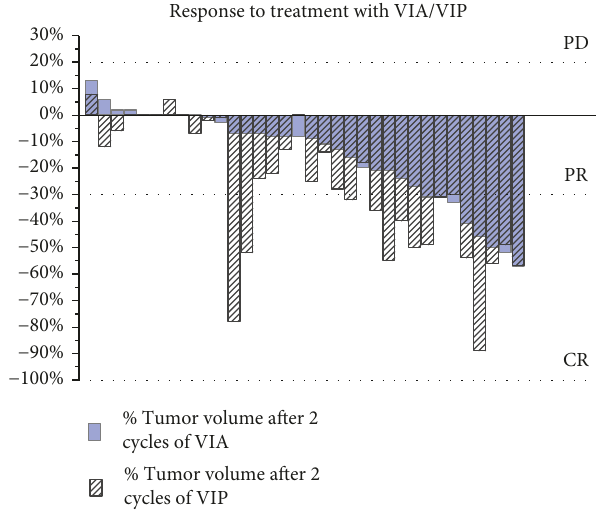
Figure 3: Radiologic response to chemotherapy with both VIA and VIP per patient ( n � 34). Only evaluable patients are shown who had imaging after 2 cycles of VIA and 2 cycles of VIP. VIA: vincristine, ifosfamide, and doxorubicin; VIP: etoposide, ifosfa- mide, and